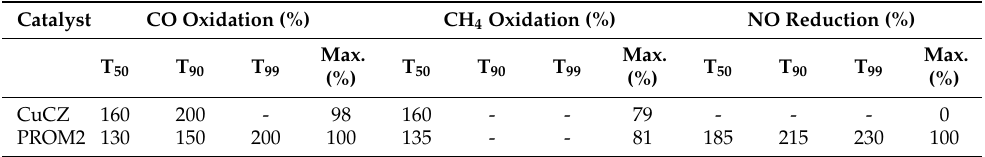
Table 5. Comparison of tested catalysts for the abatement of CO, CH 4 , NO at rich-burn conditions ( λ = 0.99).